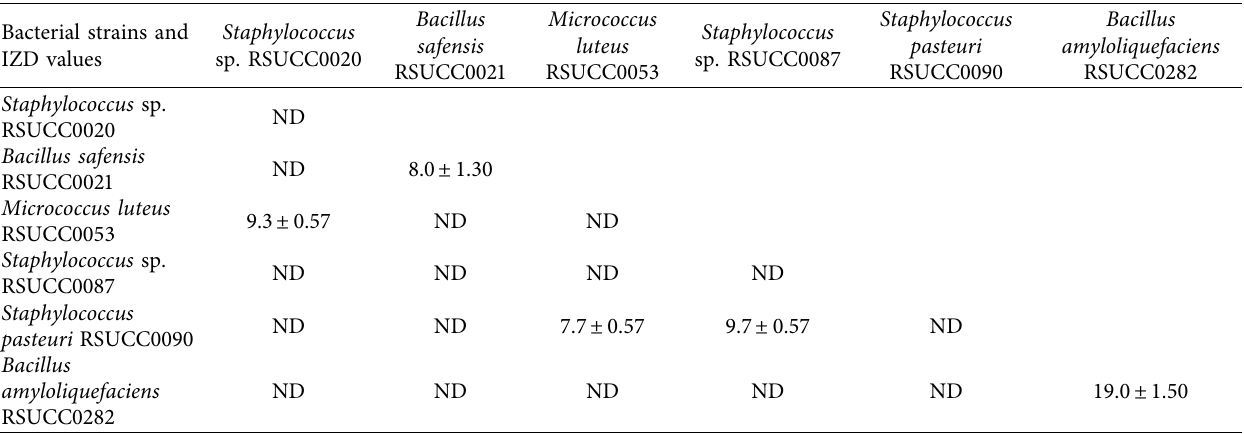
Table 3: IZD values of the crude extracts prepared from 6 bacterial strains that could inhibit the growth of Staphylococcus aureus ATCC25923 in single culture or coculture